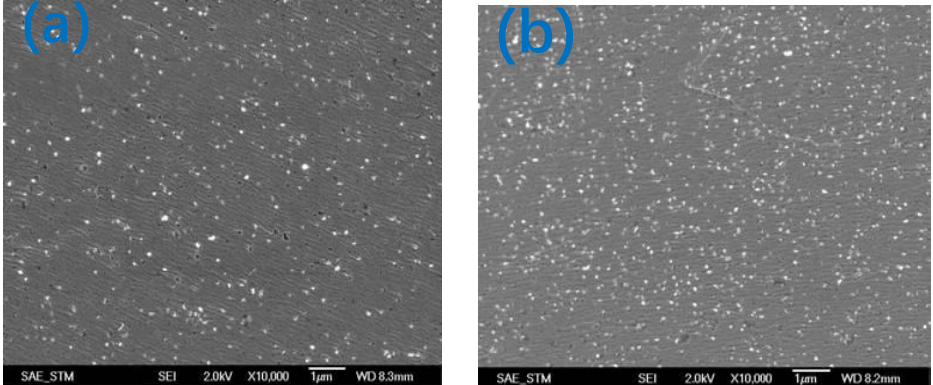
Figure 15. Keyence images of diamonds of different sizes embedded in a plate: ( a ) normal size slurry; ( b ) ultrafine slurry